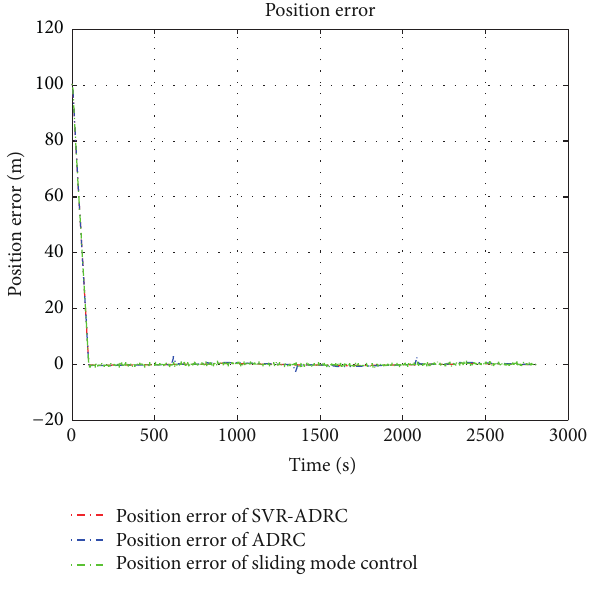
Figure 6: The position